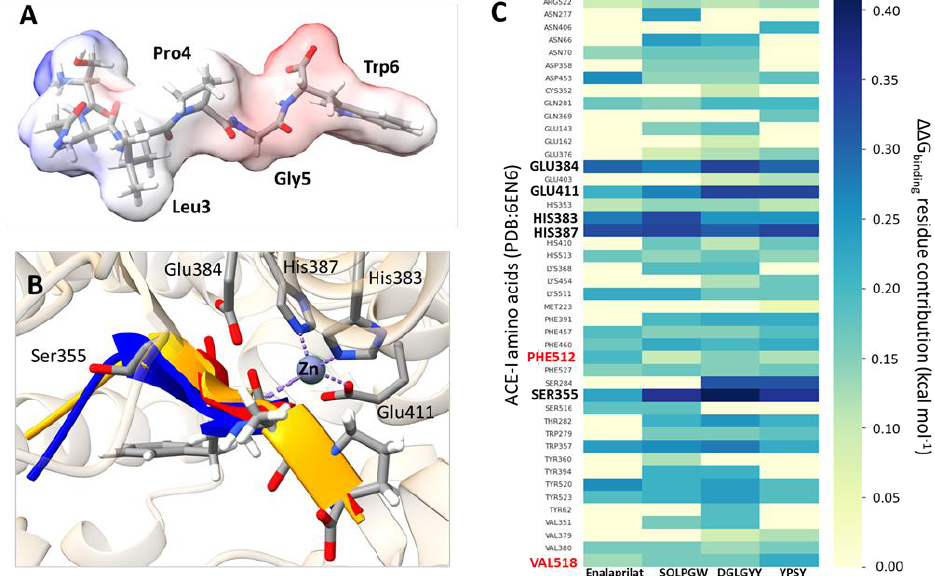
Figure 3. Molecular interactions between ACE-I and pajuro peptides after model structure refine- ment. ( A ) Representation of the SQLPGW peptide at physiological pH and its electrostatic potential isosurface showing negatively and positively charged regions in red and blue, respectively. ( B ) Side view (bottom) of the ACE-I pocket to illustrate the subsite occupancy by pajuro peptides. For pajuro peptides, only the backbone chain is shown, a chain with blue color corresponds to SQLPGW peptide, orange to DGLGYY peptide, and orange chain to YPSY peptide. Enalaprilat inhibitor atoms are shown explicitly in this representation. The figure also explicitly shows atoms of side chains from residues with higher contribution to ∆ G binding according to in silico alanine scanning. ( C ) Heat map showing the ∆ G binding contributions of ACE-I residues to their binding to pajuro peptides according to in silico alanine scanning using a DRUGSCOREPPI web server based on a knowledge- based scoring function. The name of residues with higher contributions are bold black, residues expected to have higher contributions in good ACE-I inhibitors are bold